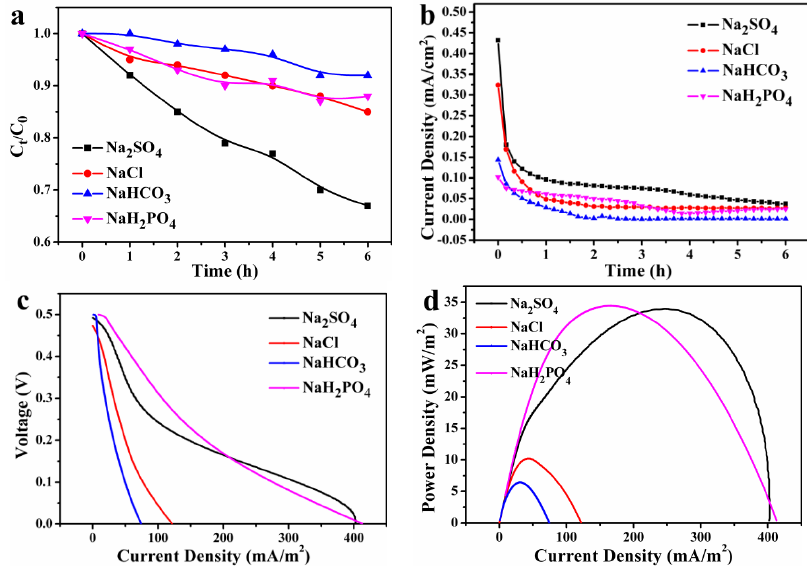
Figure 3. Effect of different electrolytes on the ( a ) 4-CP degradation; ( b )current density; ( c ) current- voltage plots and ( d ) current-power plots during the PFC operation.